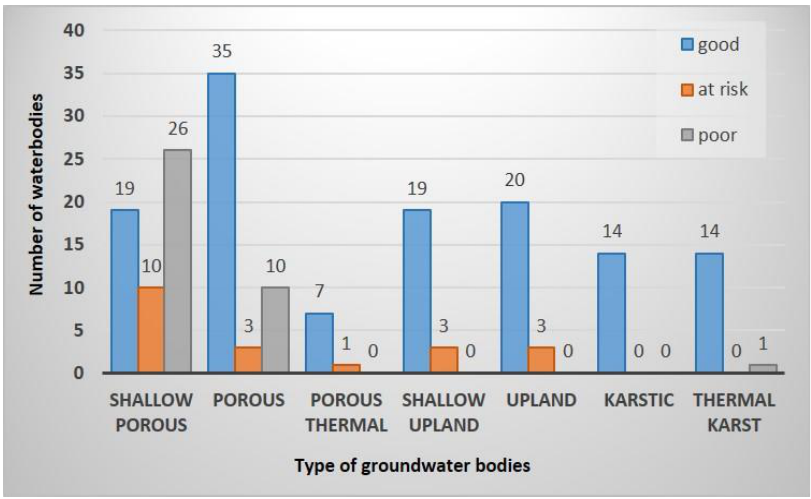
Figure 2. Qualification of quantitative state of Hungarian groundwater bodies.